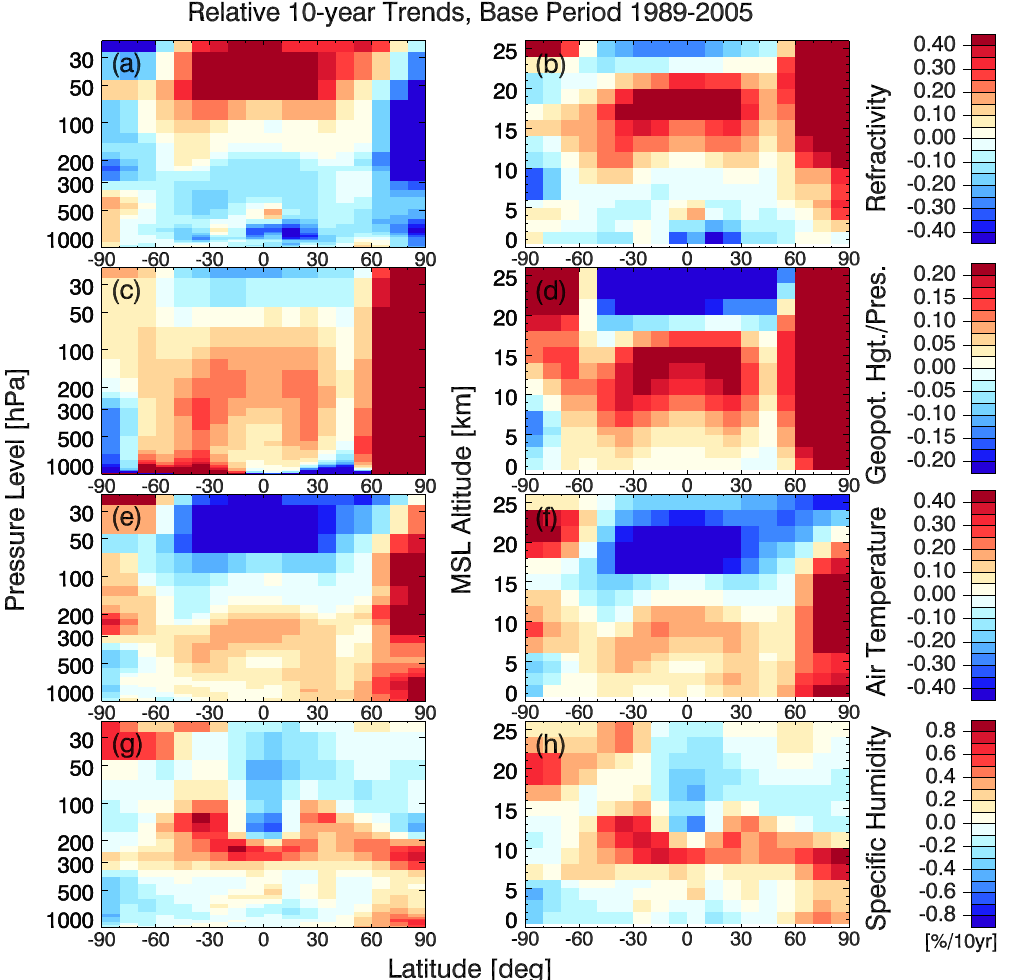
Fig. 2. Decadal trends of ERA-INT (base period 1989 to 2005). Shown are relative trend patterns for refractivity ( a – b ), geopotential height at pressure levels (c) and pressure at MSL altitudes (d) , temperature ( e – f ), and specific humidity ( g – h ). The left column shows patterns as function of constant pressure levels, the right column as function of MSL